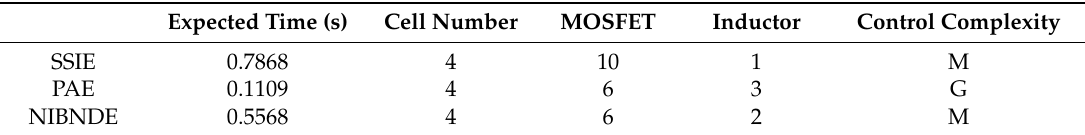
Table 3. The comparison between SSIE, PAE and NIBNDE in four cells battery string (G: Good; M: Marginal; P: Poor).